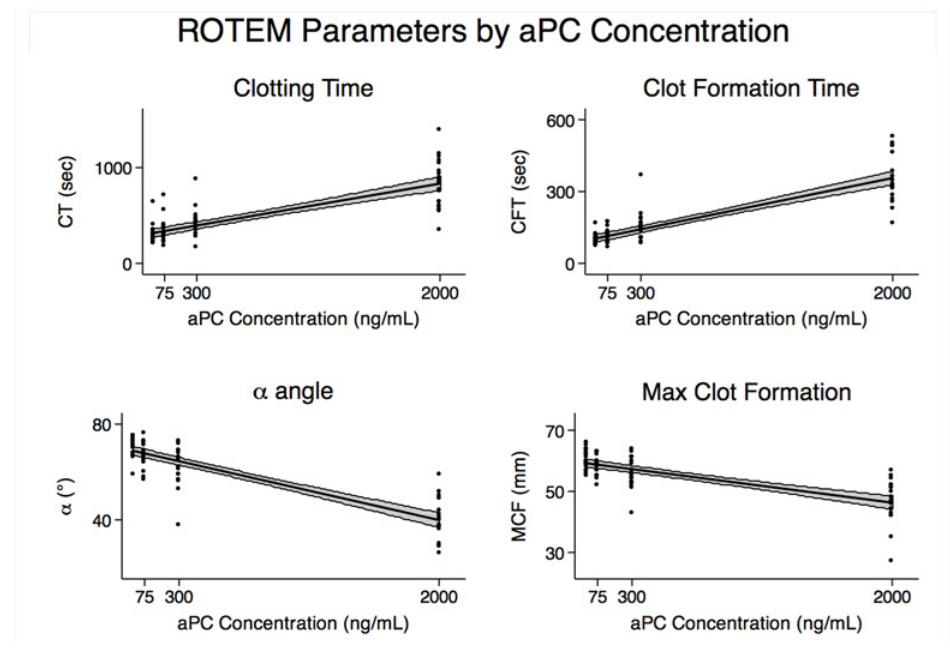
Fig 2. Linear regression analysis of ROTEM parameters. ROTEM EXTEM parameters changed significantly by aPC concentration, with strong linear correlation between aPC concentration and prolonged clotting time (CT) and clot formation time (CFT), decreased alpha angle ( α ), and reduced maximum clot firmness (MCF). The coefficients of these changes are delineated in Table 1.